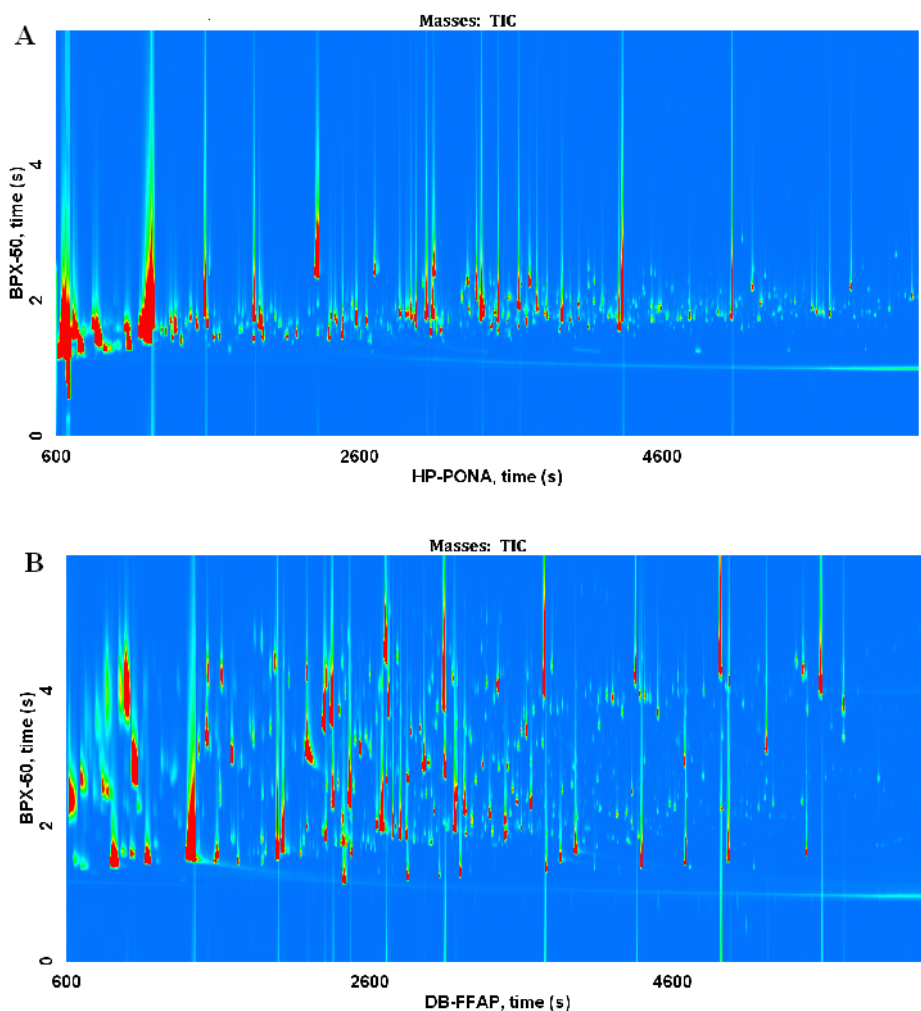
Figure 1: GCxGC-TOF-MS chromatograms using columns (A) HP-PONA and BPX-50, (B) DB-FFAP and